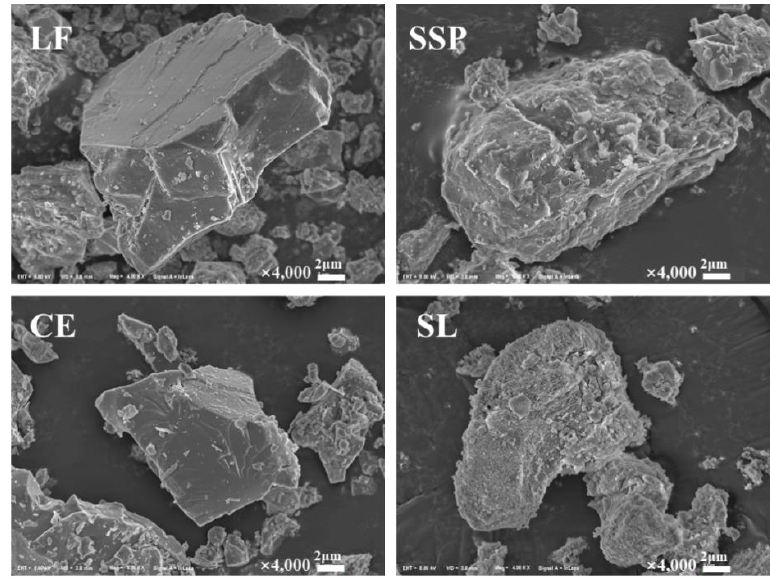
Figure 4. SEM images of the four fillers.